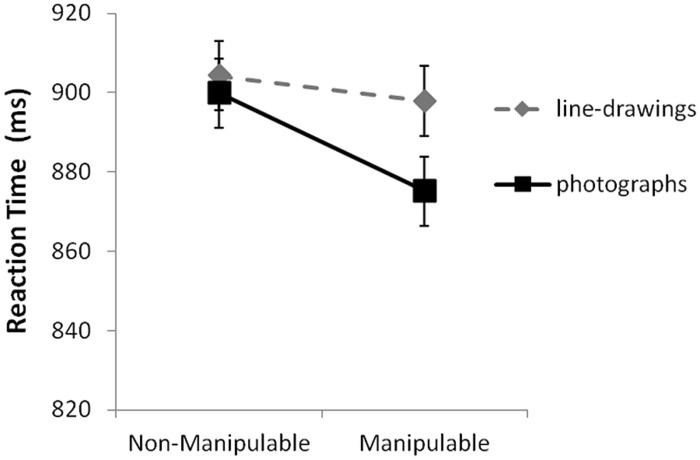
The reaction time (RT) means for the two-way interaction between Depiction and Manipulability, showing larger effects of object depiction (photographs versus line drawings) for manipulable objects. Error bars shown indicate confidence intervals calculated according to the method described by Masson and Loftus (2003; see also Loftus and Masson, 1994).